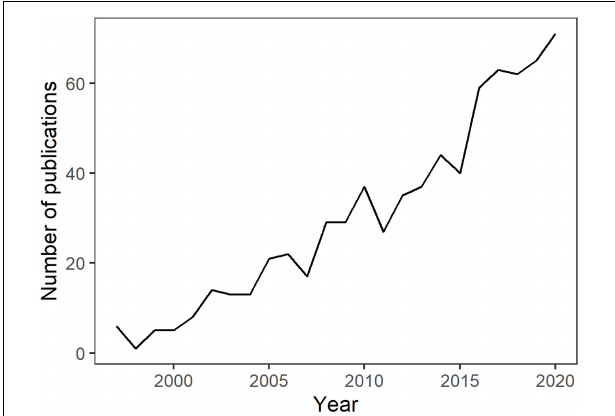
FIGURE 1 | Number of publications per year recorded in the Web of Science databases between 1995 and 2020 using the search terms: “aquarium trade” and “aquatic ornamental